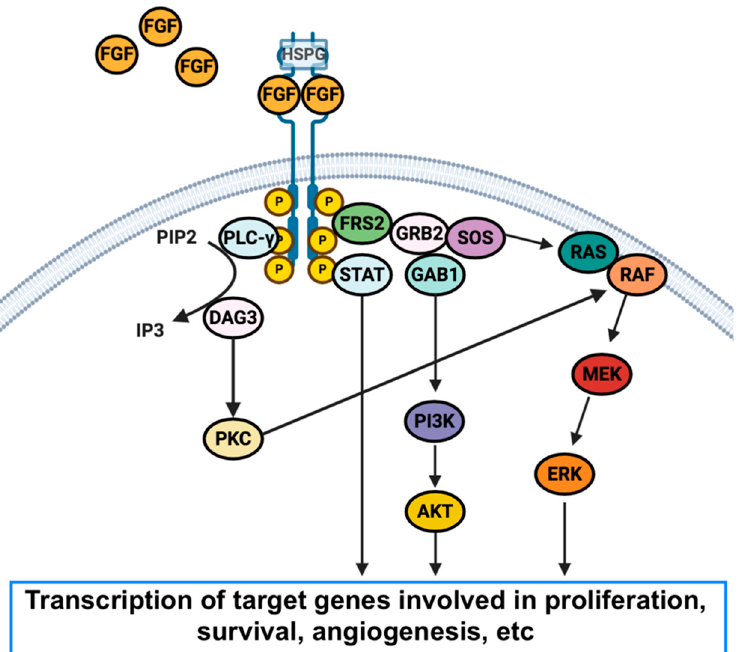
Figure 1. Schematic figure that represents the fibroblast growth factor receptor’s (FGFR) structure, network, and alteration in cancer. Abbreviations: FRS2: fibroblast growth factor receptor substrate 2; HSPG: heparan sulfate proteoglycan; PLC- γ : phospholipase gamma; PIP2: phosphatidylinositol 4,5-bisphosphate; IP3: phosphatidylinositol 3,4,5-triphosphate; DAG: diacylglycerol; PKC: protein kinase C; GRB2: growth factor receptor-bound protein 2; GAB1: GRB2-associated-binding protein; MEK: MAPK/ERK kinase.